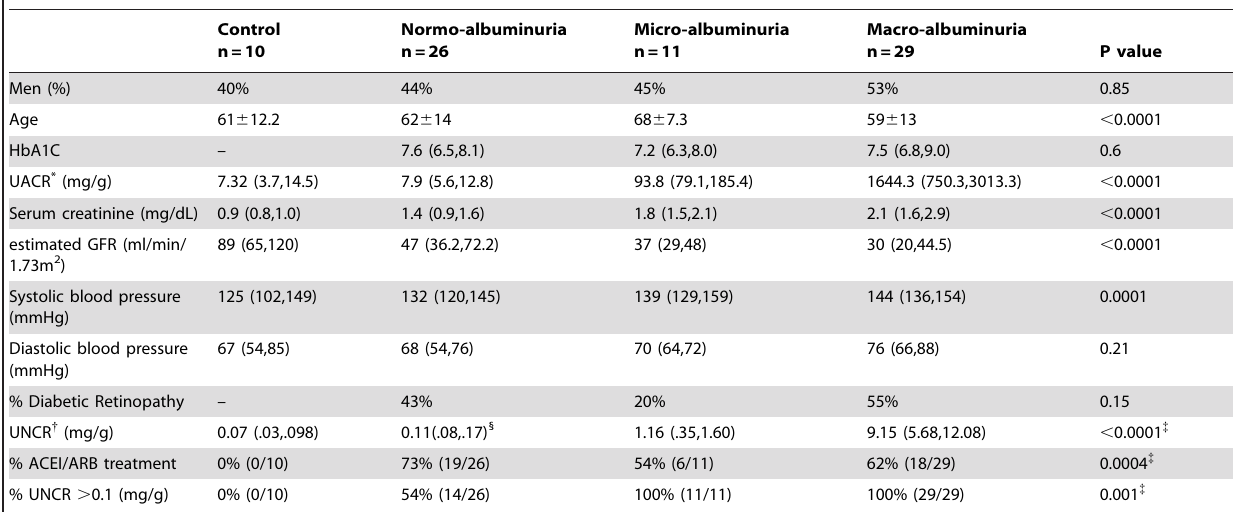
Table 2. Clinical parameters of control and type 2 diabetic patients.